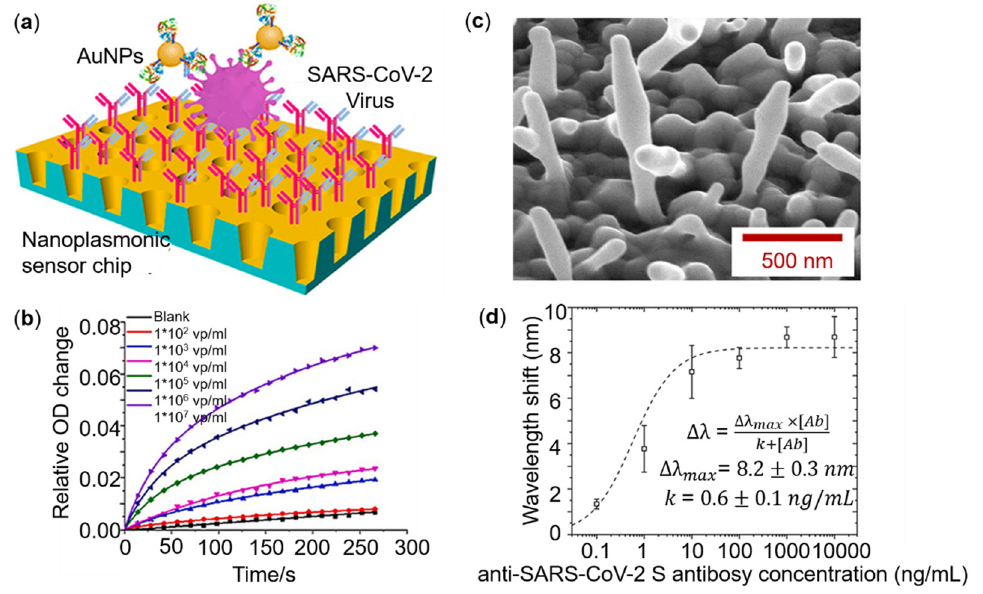
Figure 5. Different structures and sensing properties of SARS-CoV-2 detection. ( a ) Schematic diagram of nanocup array for COVID-19 detection. ( b ) SARS-CoV-2 mAbs labeled AuNP enhanced binding curves with different concentrations of the SARS-CoV-2 pseudo virus over the range 0–1.0 × 10 7 vp/mL. ( c ) SEM diagram of nano spikes structure. ( d ) LSPR responses at different anti-SARS-CoV-2 spike protein antibody concentrations. Reprinted ( a , b ) with permission from Reference [140]. Reprinted ( c , d ) with permission from Reference [141].